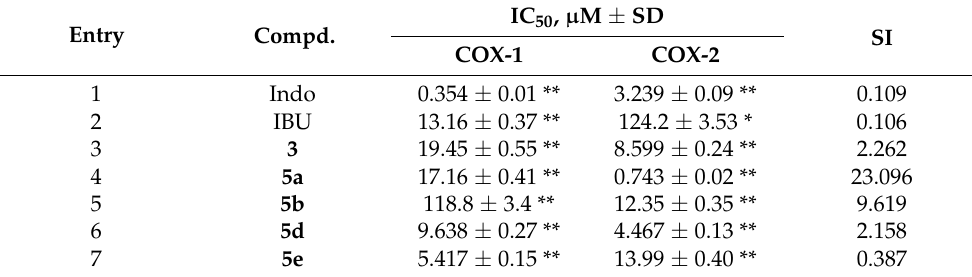
Table 5. COX-1 and COX-2 inhibitory properties of the tested